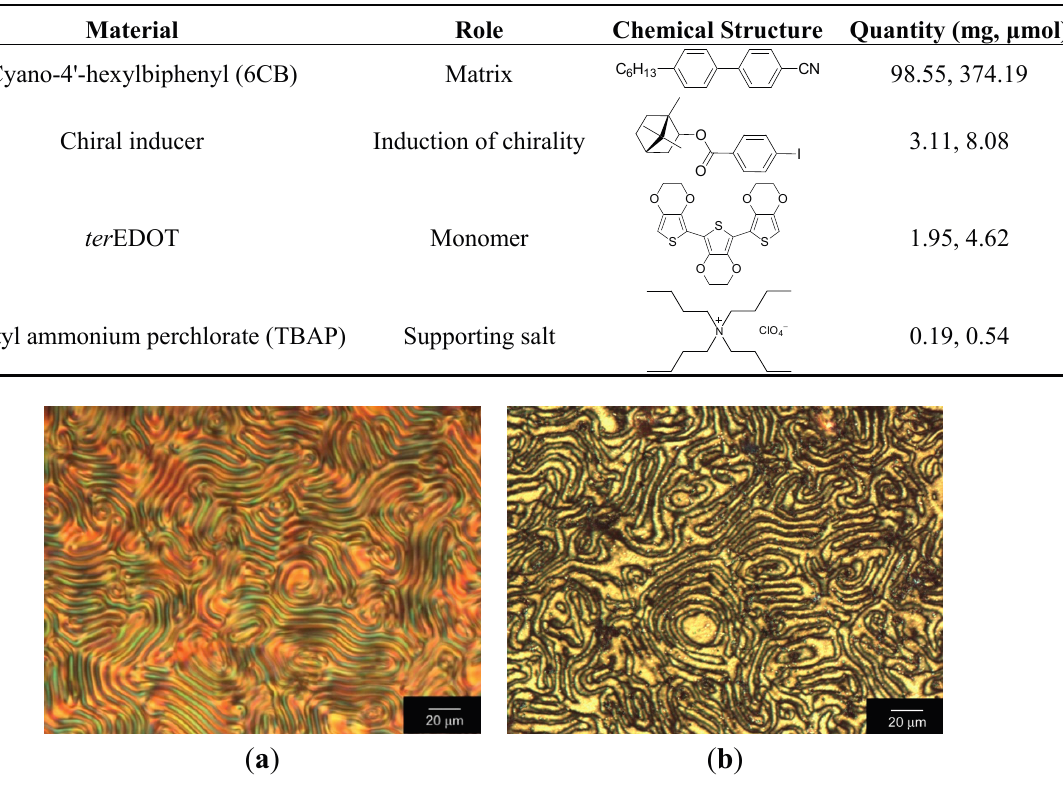
Figure 2. ( a ) Polarizing optical microscopy ( POM) image of cholesteric liquid crystal electrolyte solution containing monomer at 19 °C. ( b ) POM image of the polymer film